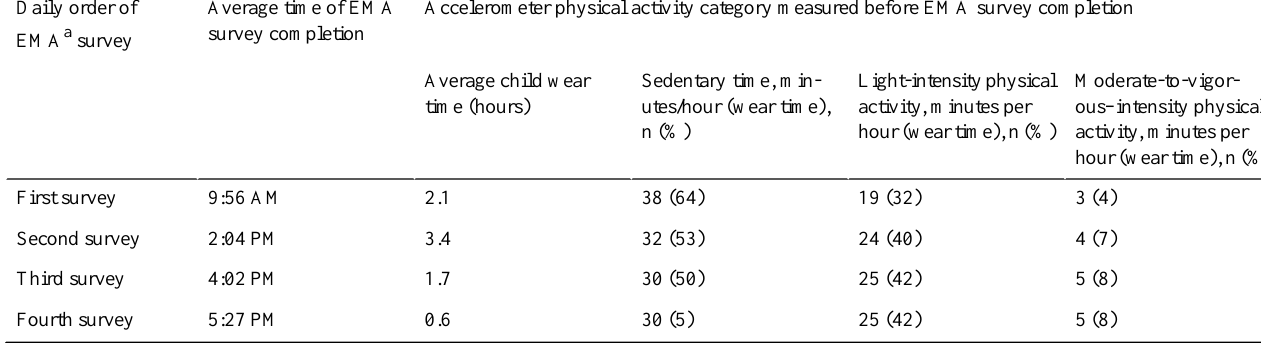
Table 1. Accelerometer-measured average minutes of the child’s physical activity and the composition of physical activity category by the time of ecological momentary assessment survey completion (N=140 for respondents; N=944 for observation days; and N=3127 for ecological momentary assessment